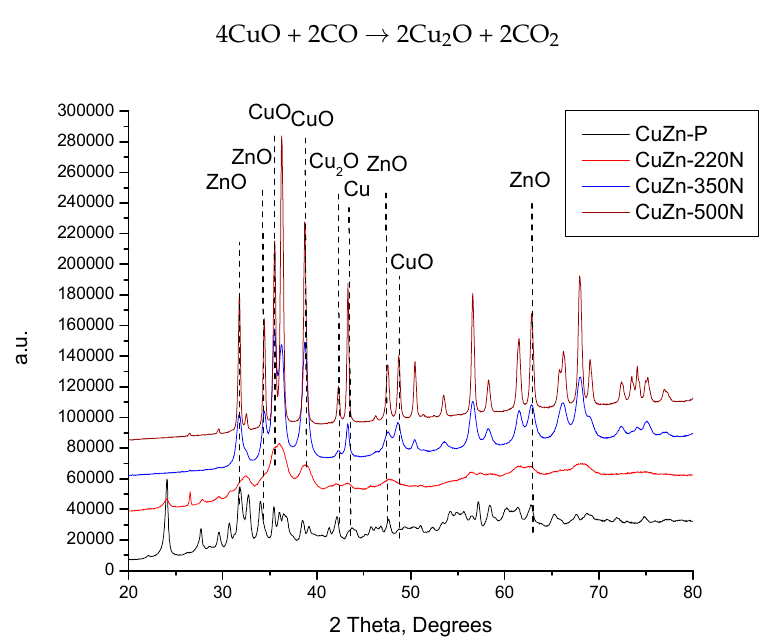
Figure 2. The XRD patterns of catalysts prepared by the treatment of the CuZn precursor in flowing nitrogen at 220, 350, and 500 °C.